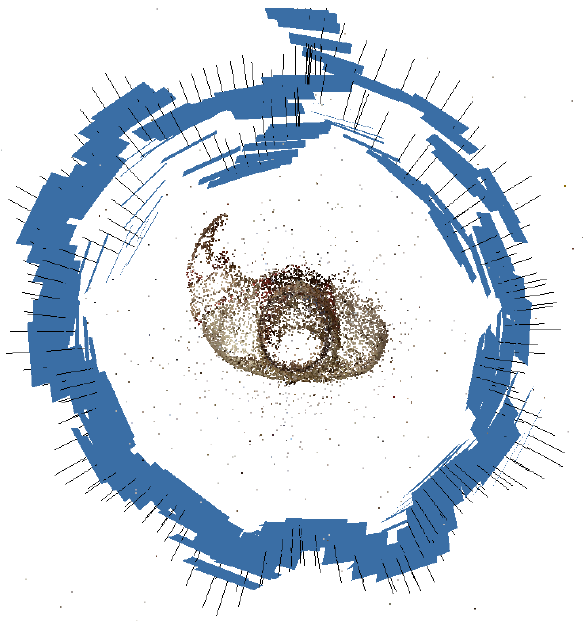
Figure 5: The aligned image frames (top view)